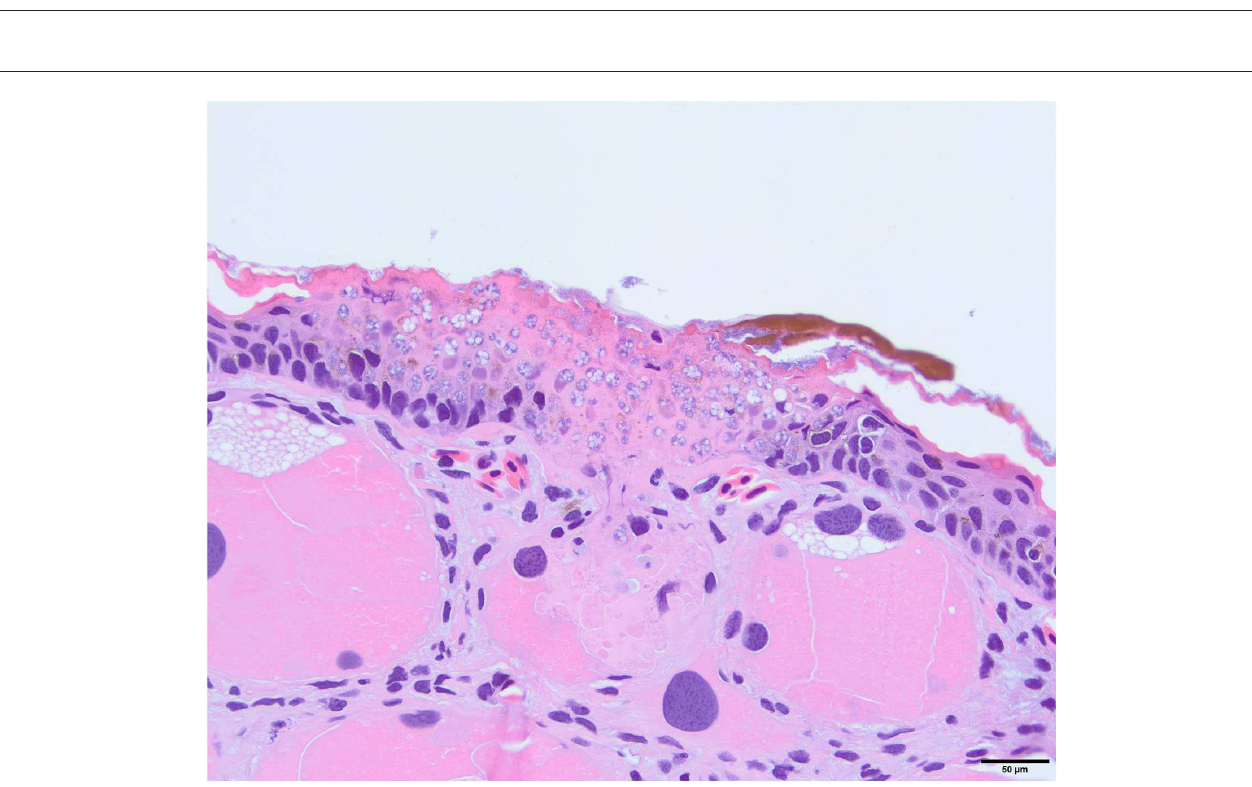
FIGURE16 Photomicrograph stained with hematoxylin and eosin (H&E) showing invasion of Batrachochytrium salamandrivorans ( Bsal ) thalli into a dermal granular gland. There is full thickness invasion of the overlying epidermis by Bsal thalli along with associated epithelial damage.